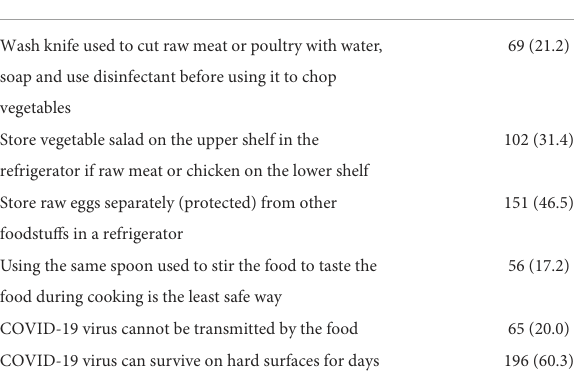
TABLE 4 Query statements and responses a of “cross-contamination prevention” domain ( n =